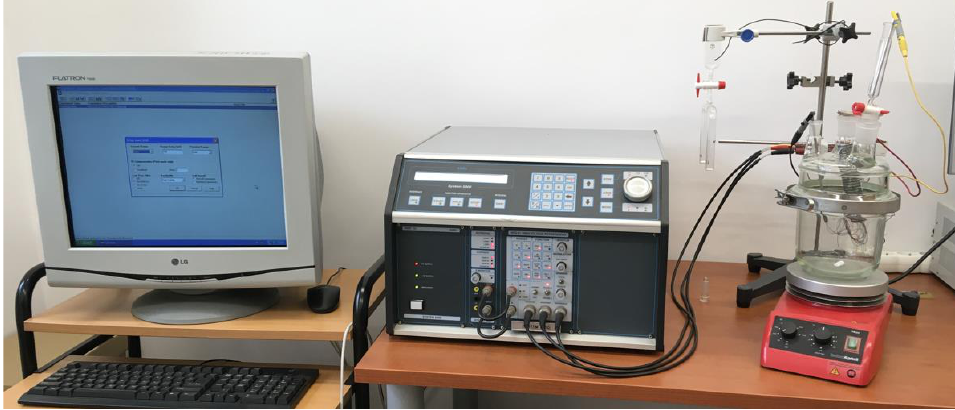
Figure 5. Measurement setup for the measurements of WEO electrooxidation.